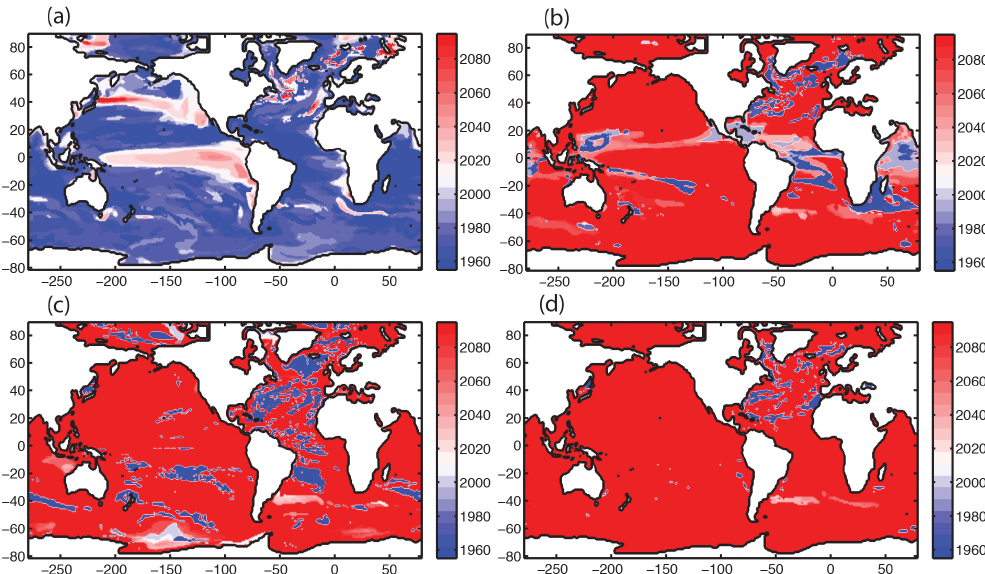
Figure A5. The time of emergence (ToE) for each of the four drivers has been calculated using a 10-year window for the calculation of trends, considering the time interval 1955–2095. Time of emergence (ToE), calculated using a threshold of 1 standard deviation (67% confidence) for (a) (cid:127) arag , (b) SST, (c) O 2 inventories over 100–600m and (d) NPP. The color scheme has been chosen to distinguish between relative to the present (2014) with shades of blue indicating a ToE post-2014 and shades of red indicating a ToE pre-2014. This is the complement to the results with ToE for a 30-year window, shown in Fig. 6.